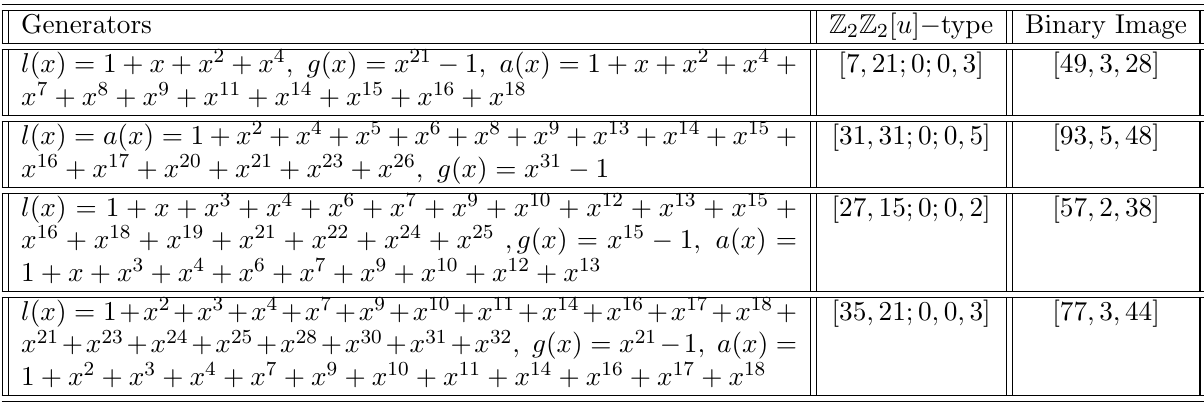
Table 1. Some Examples of One Weight Z 2 Z 2 [ u ]-cyclic